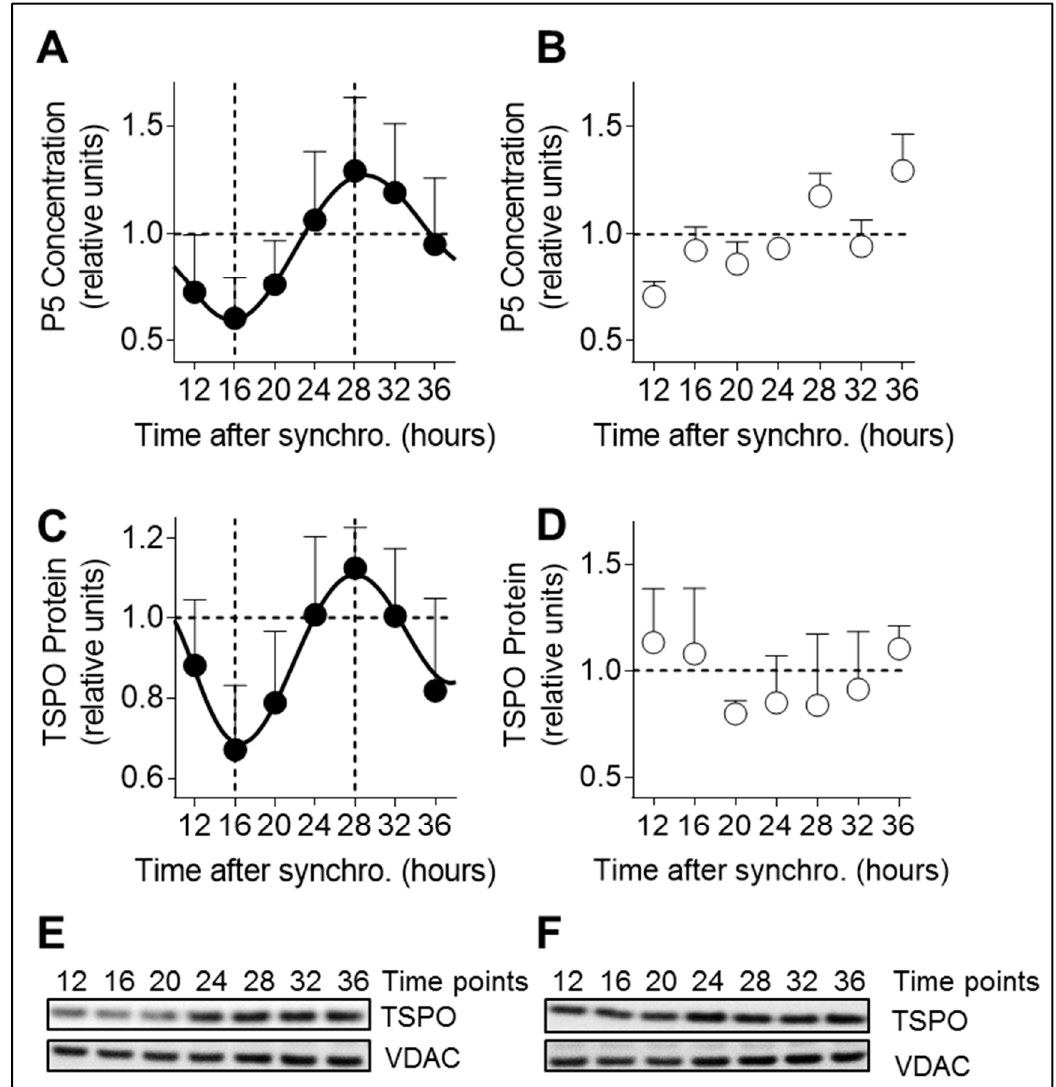
Figure 1. Pregnenolone and TSPO oscillations are dependent on a functional circadian clock in A172 cells. ( A ) P5 (pregnenolone) concentration was quantified in lysates from synchronized A172 glioma cells using a direct pregnenolone ELISA test. Time points from 12 to 36 h post-synchronization are shown. All data are normalized to 1 and presented as mean ± SD (three independent experiments, seven time points, n = 12 for each time point). ( B ) P5 concentration in synchronized PER1/PER2 siRNA transfected A172 glioma cells. Time points from 12 to 36 h post-synchronization are shown. All data are normalized to 1 and presented as mean ± SD (three independent experiments, seven time points, n = 3–5 for each time point). ( C ) Translocator protein (TSPO) levels were analyzed in cell lysates from synchronized A172 glioma cells by immunoblotting. Time points from 12 to 36 h post-synchronization are shown. All data are normalized to 1 and presented as mean ± SD (three independent experiments, seven time points, n = 4–6 for each time point). ( D ) TSPO protein levels in synchronized PER1/PER2 siRNA transfected A172 glioma cells. Time points from 12 to 36 h post-synchronization are shown. All data are normalized to 1 and presented as mean ± SD (two independent experiments, seven time points, n = 3–5 for each time point). ( E ) Representative immunoblots of synchronized A172 glioma cell lysates stained with antibodies specific for TSPO and VDAC (voltage-dependent anion-selective channel = control). Time points from 12 to 36 h post-synchronization are shown. ( F ) Representative immunoblots of synchronized PER1/PER2 siRNA transfected A172 cells stained with antibodies specific for TSPO and VDAC (control). Time points from 12 to 36 h post-synchronization are shown.